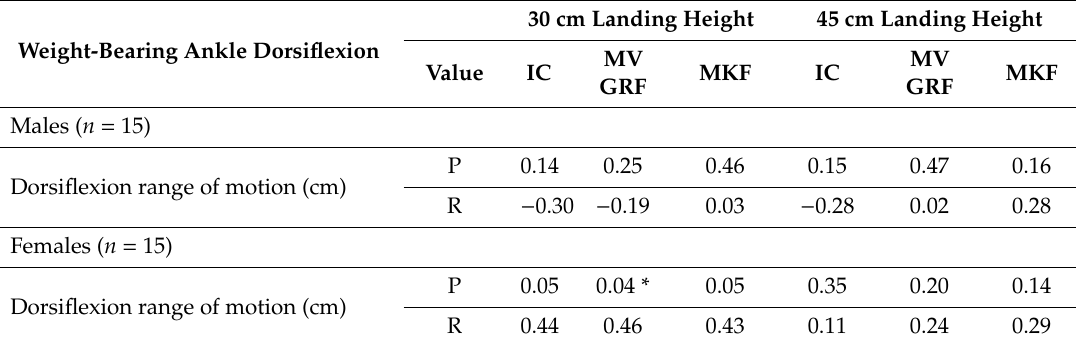
Table 3. Relationship between ankle dorsiflexion range of motion and knee angle during landing among male and female university athletes ( n = 30).